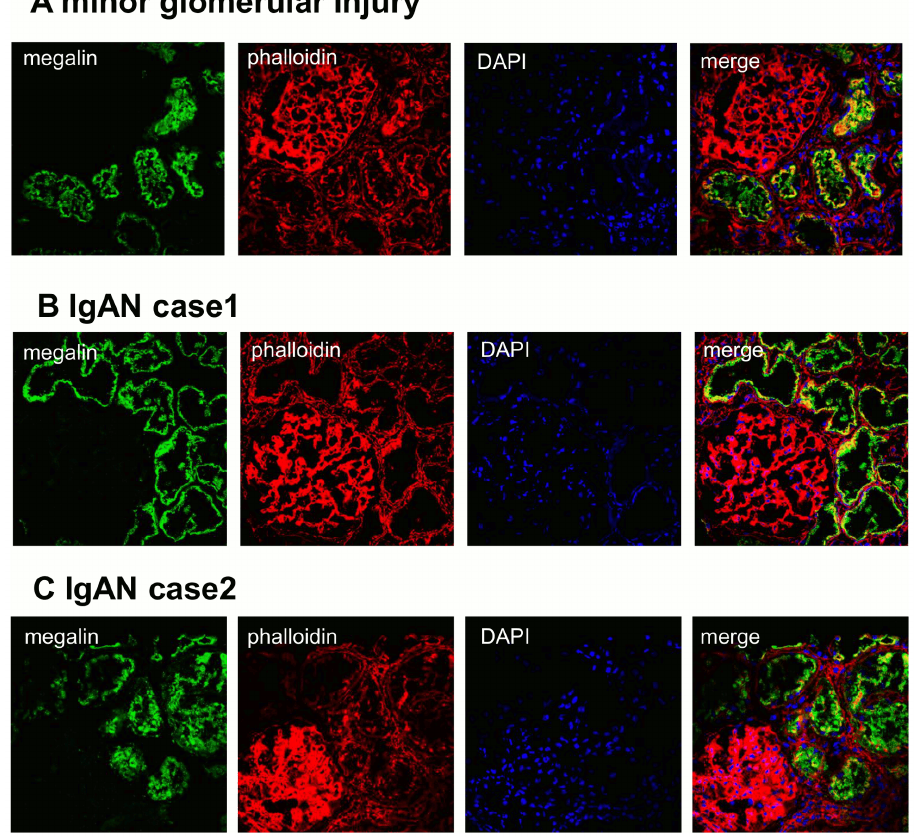
Fig. 2. Triple staining for megalin, phalloidin and DAPI in renal biopsy specimens from IgAN patients. Triple staining for megalin, phalloidin and DAPI in renal biopsy specimens from minor glomerular injury patients (A) and IgAN patients (B, C) showed that megalin was localized in the brush border of proximal tubules.